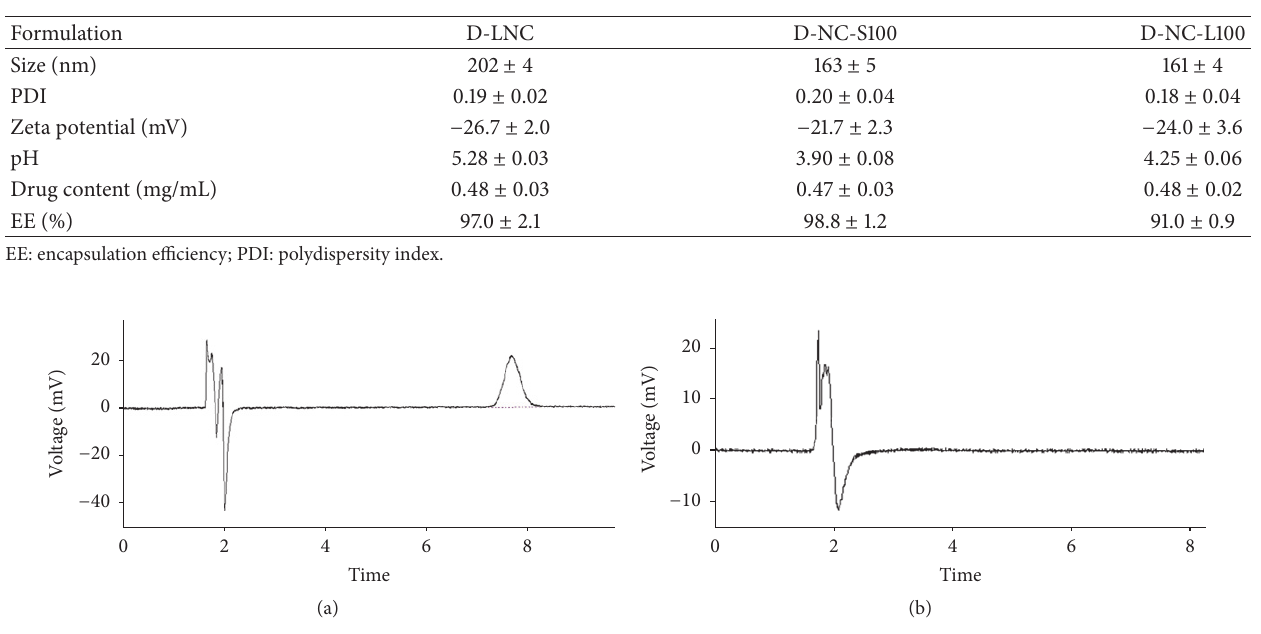
Table 1: Physicochemical characteristics of desonide-loaded nanocapsule suspensions.